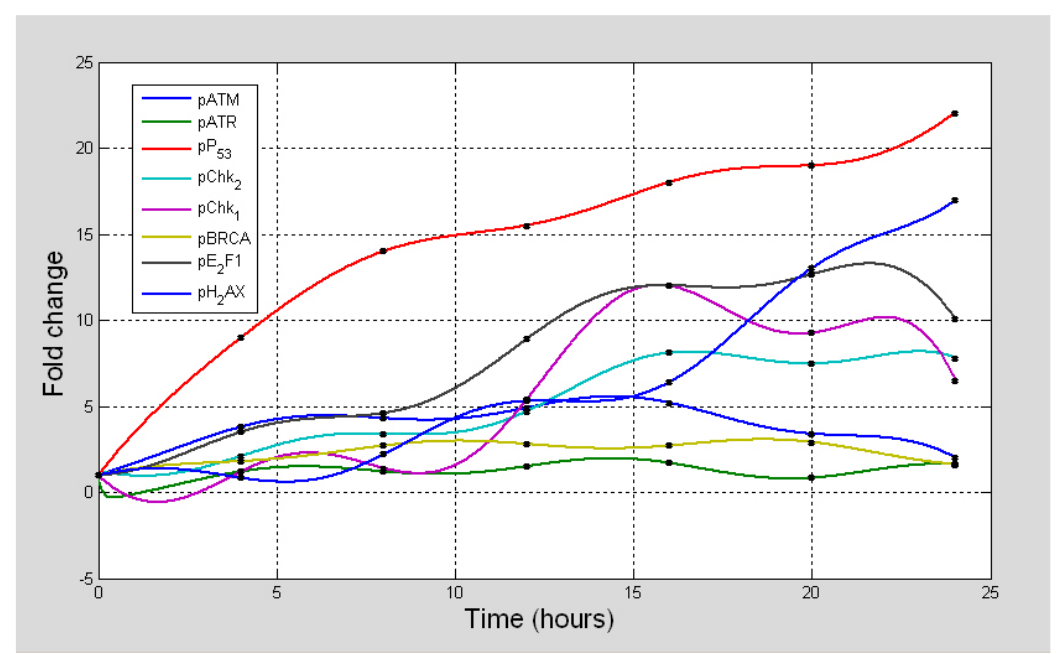
Figure 14. Simulated system dynamics of the DDR pathway that are most consistent with the historical time series measure- ments at (0.4 µ M) dose-intensities of doxorubicin without KU treatment.